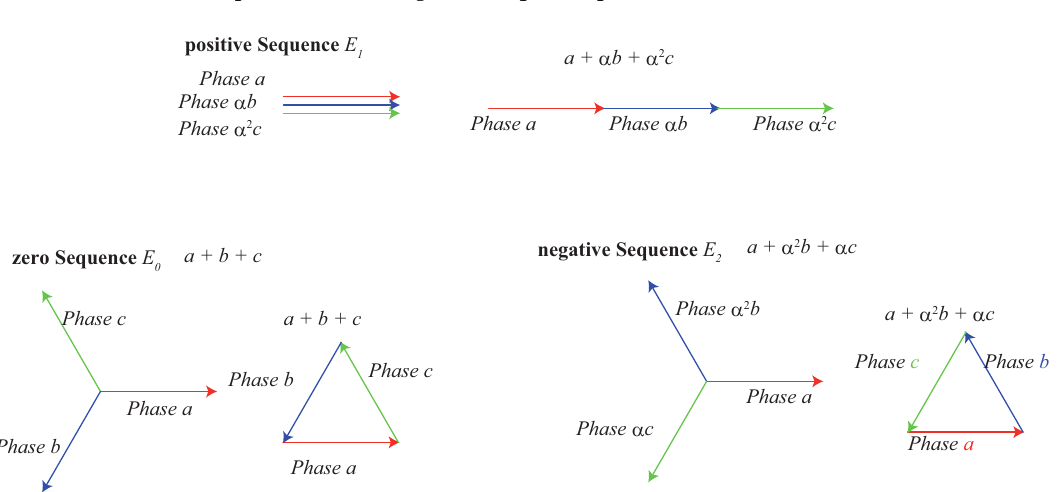
Figure 2. A visualization of the symmetrical components in balanced three-phase conditions.